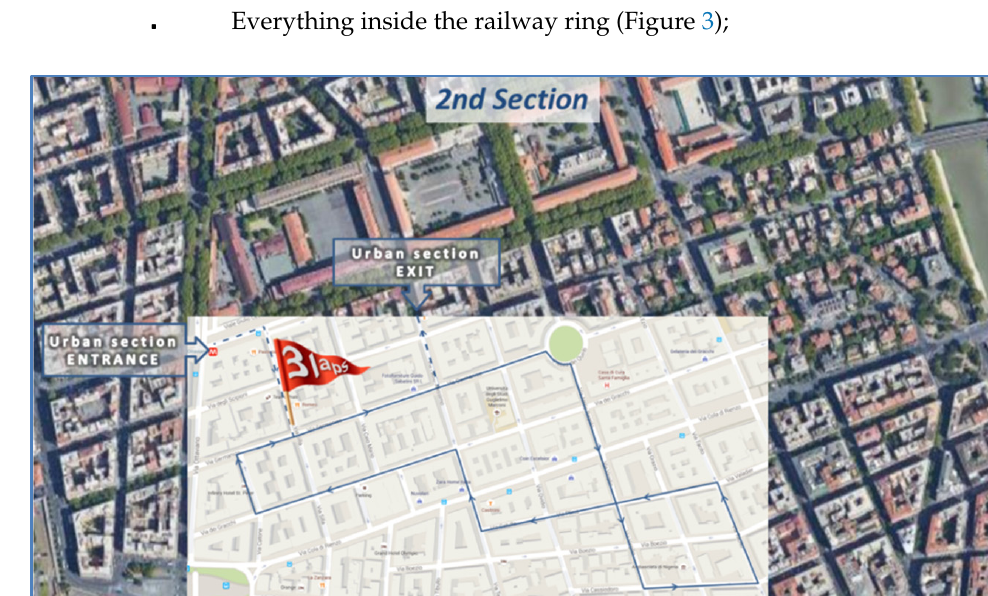
Figure 3. Urban: route that develops over three laps.